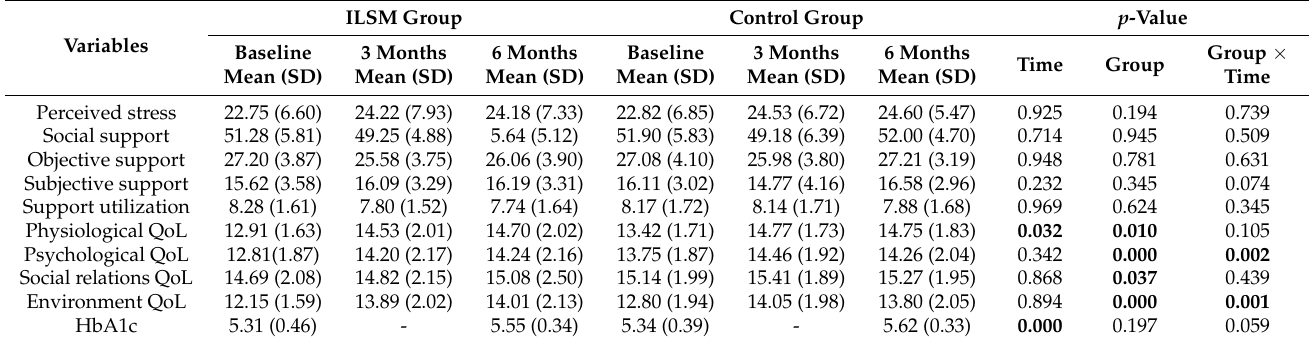
Table 2. The effects of the intensive lifestyle modification (ILSM) intervention on perceived stress, social support, quality of life (QoL), and